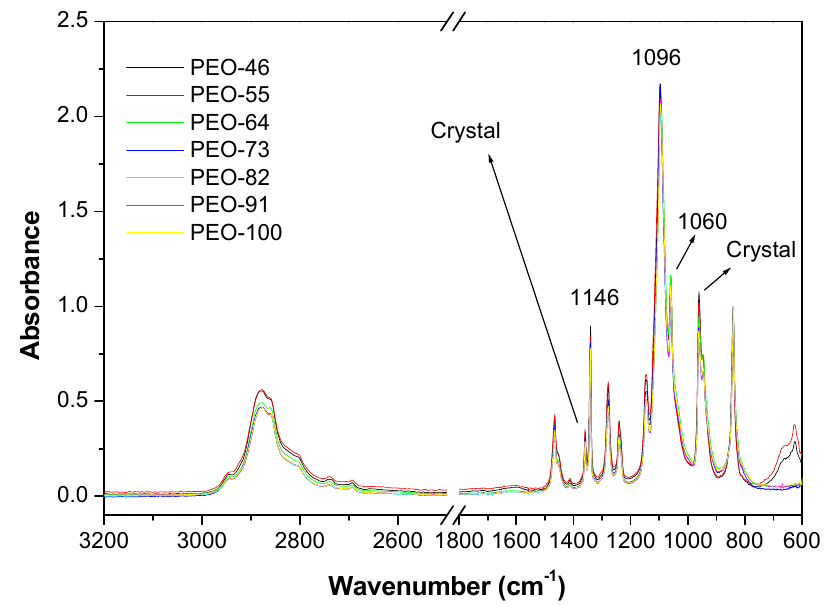
Figure 2. ATR-FTIR spectra of the blow spun PEO-based obtained from 10% wt solutions at different compositions